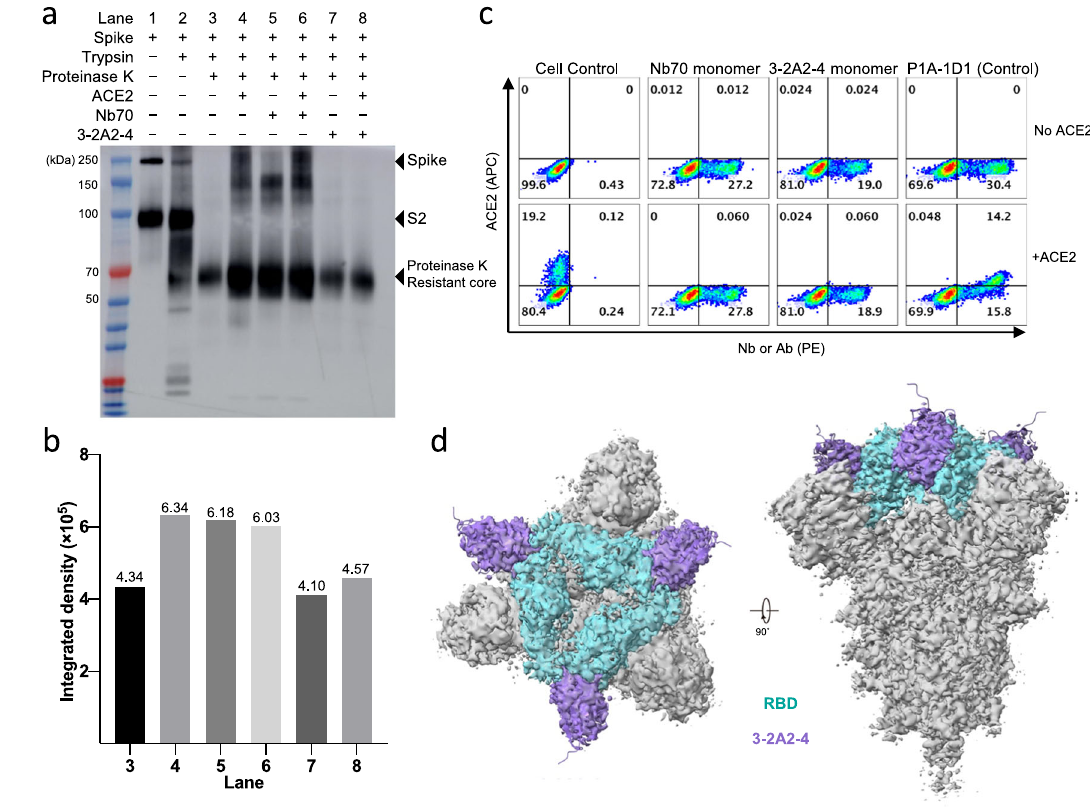
Fig. 5 | Mechanism of action of Nb70 and 3-2A2-4. a The effect of monomeric Nb70 and 3-2A2-4 nanobodies on the conformational change of the SARS-CoV-2 S trimer probed by western blotting using an anti-SARS-CoV-2 S2 polyclonal anti- body. Refolding to the post-fusion conformation was detected by the appearance of a proteinase K-resistant core. Digestion experiments and western blots were performed in triplicates, and one representative result is shown. b The integrated density of proteinase K-resistant core in each lane was calculated by ImageJ. c Competitive binding of monomeric Nb70 and 3-2A2-4 nanobodies with soluble ACE2toprototypeSARS-CoV-2spikemeasuredbycellsurfacestaining.Spikewere expressed on the surface on HEK293T, incubated with the Nb70 or 3-2A2-4